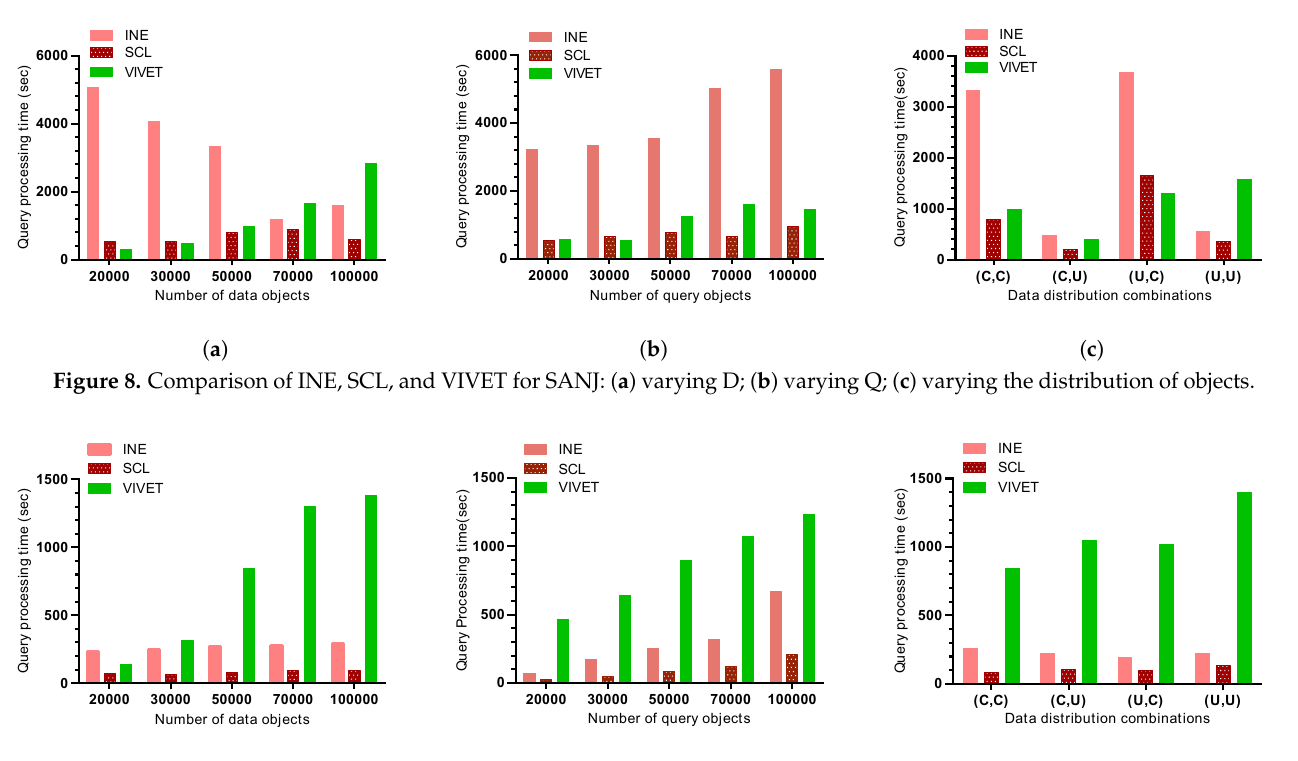
Number of data objects